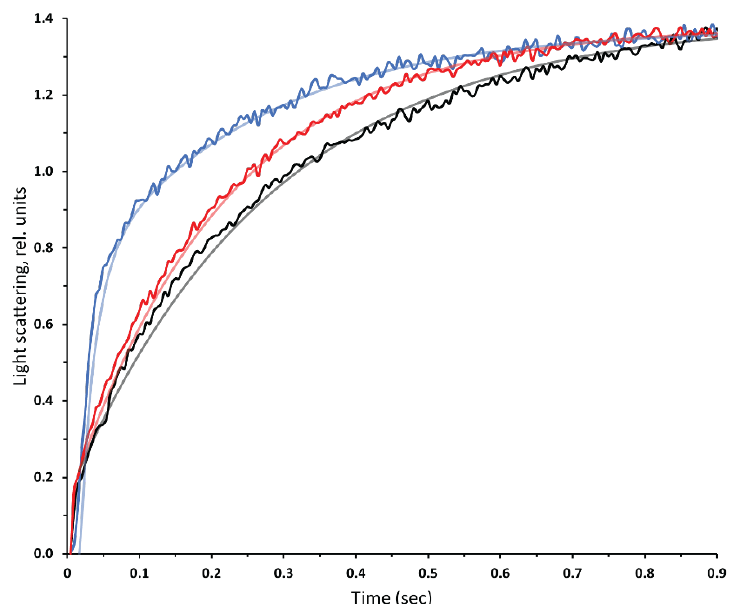
Figure 4. Kinetics of light scattering changes in PC/PS liposomes under hypertonic shock produced in the stopped-flow apparatus. Proteoliposomes reconstituted with hAQP2 at a protein:lipid ratio of 10:1 (w/w) (blue), the same proteoliposomes incubated with 0.1 mM HgCl 2 (red), and PC/PS liposomes with no protein (black). Each trace is an average of 15 measurements and the exponential decay fits are displayed over the raw data (see text for details).